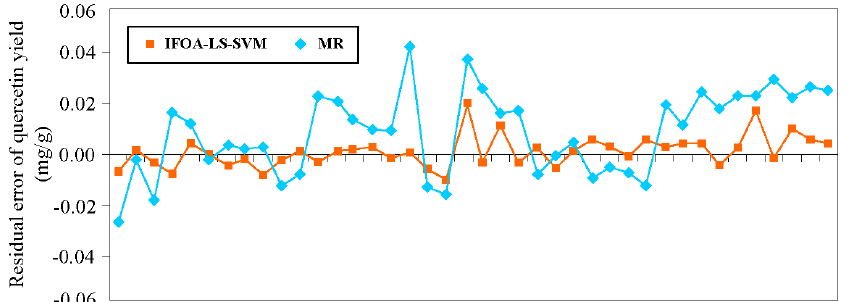
Figure 14. Residual error of the values predicted by IFOA ‐ LS ‐ SVM and MR models from the experimental values.